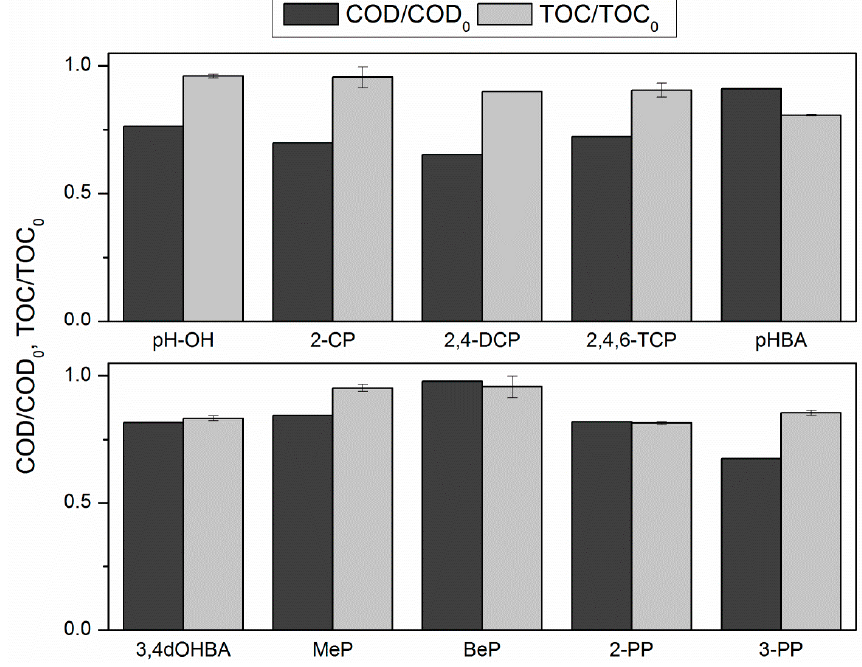
Figure 8. Comparison of the relative decreases in COD and TOC.